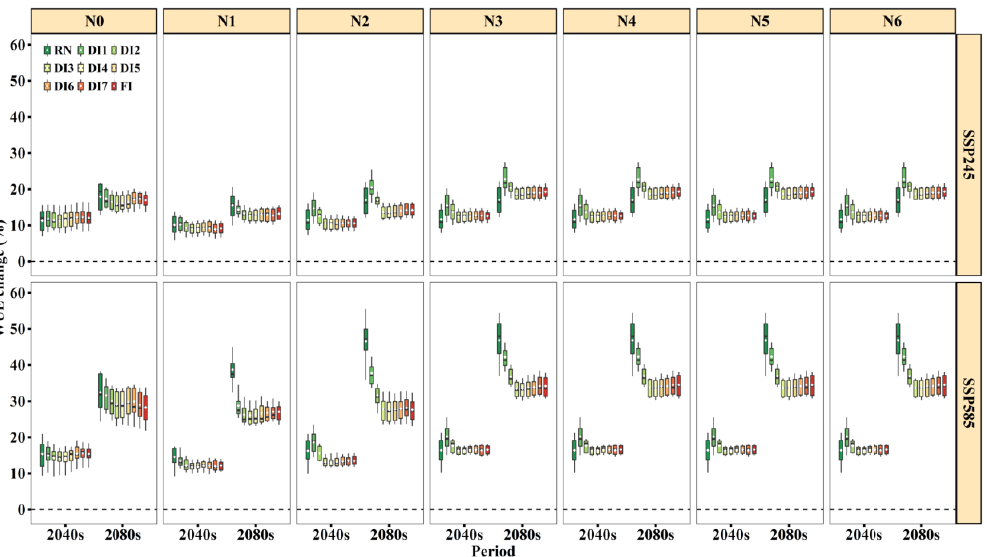
Figure 5. WUE change for nine irrigation treatments under N fertilizer rates in the 2040s and 2080s relative to the baseline (1961–2000) under SSP245 and SSP585 based on 21 GCMs. Box boundaries indicate the 25th and 75th percentiles across GCMs, and whiskers below and above the box denote the 10th and 90th percentiles. The black lines and white dots inside the box indicate the multi-model median and mean, respectively.